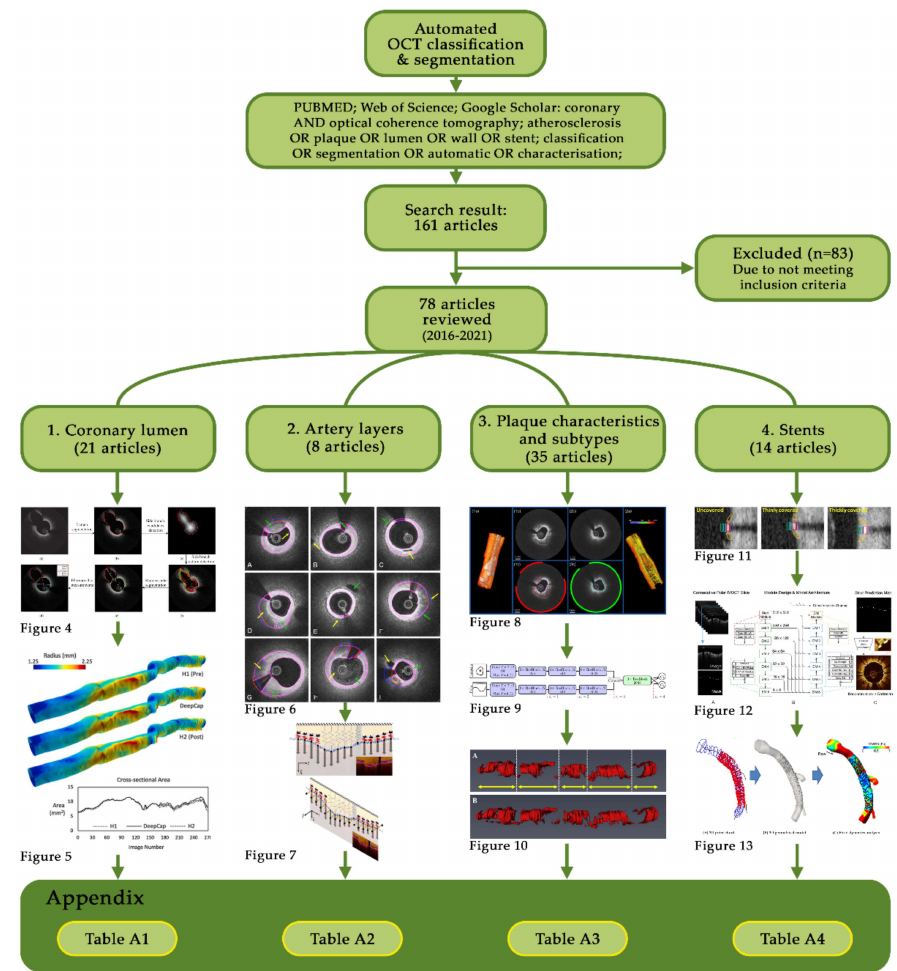
Figure 3. Consort diagram showing the review layout and Appendix A tables for each